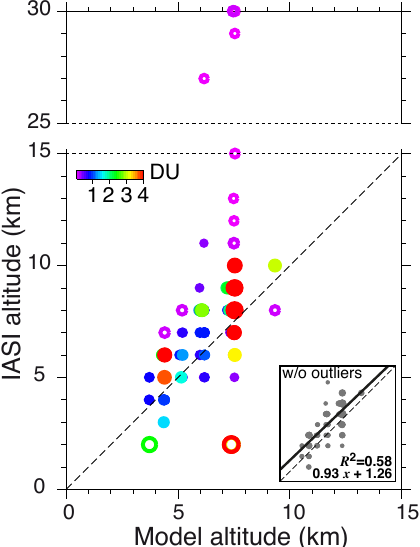
Figure 11. Scatter plot of the altitude of the Etna SO 2 cloud re- trieved from IASI observations with the modelled altitude predicted with the CHIMERE model initialized with emissions reconstructed from the inversion of IASI SO 2 column amounts (DU). All data from 10 April a.m. to 11 April p.m. 2011 are included. Symbol colour and size depend on IASI SO 2 column amount (DU). Open circles correspond to IASI outlier altitudes discussed in Sect. 4.2, associated to pixels with SO 2 CA < 0.3 DU (detection threshold) or pixels with both altitudes ≤ 2km and SO 2 CA ≥ 4DU). Inset plot shows the linear regression between observed and modelled al- titudes without these outliers. Note the change of scale in the Y axis at an altitude >